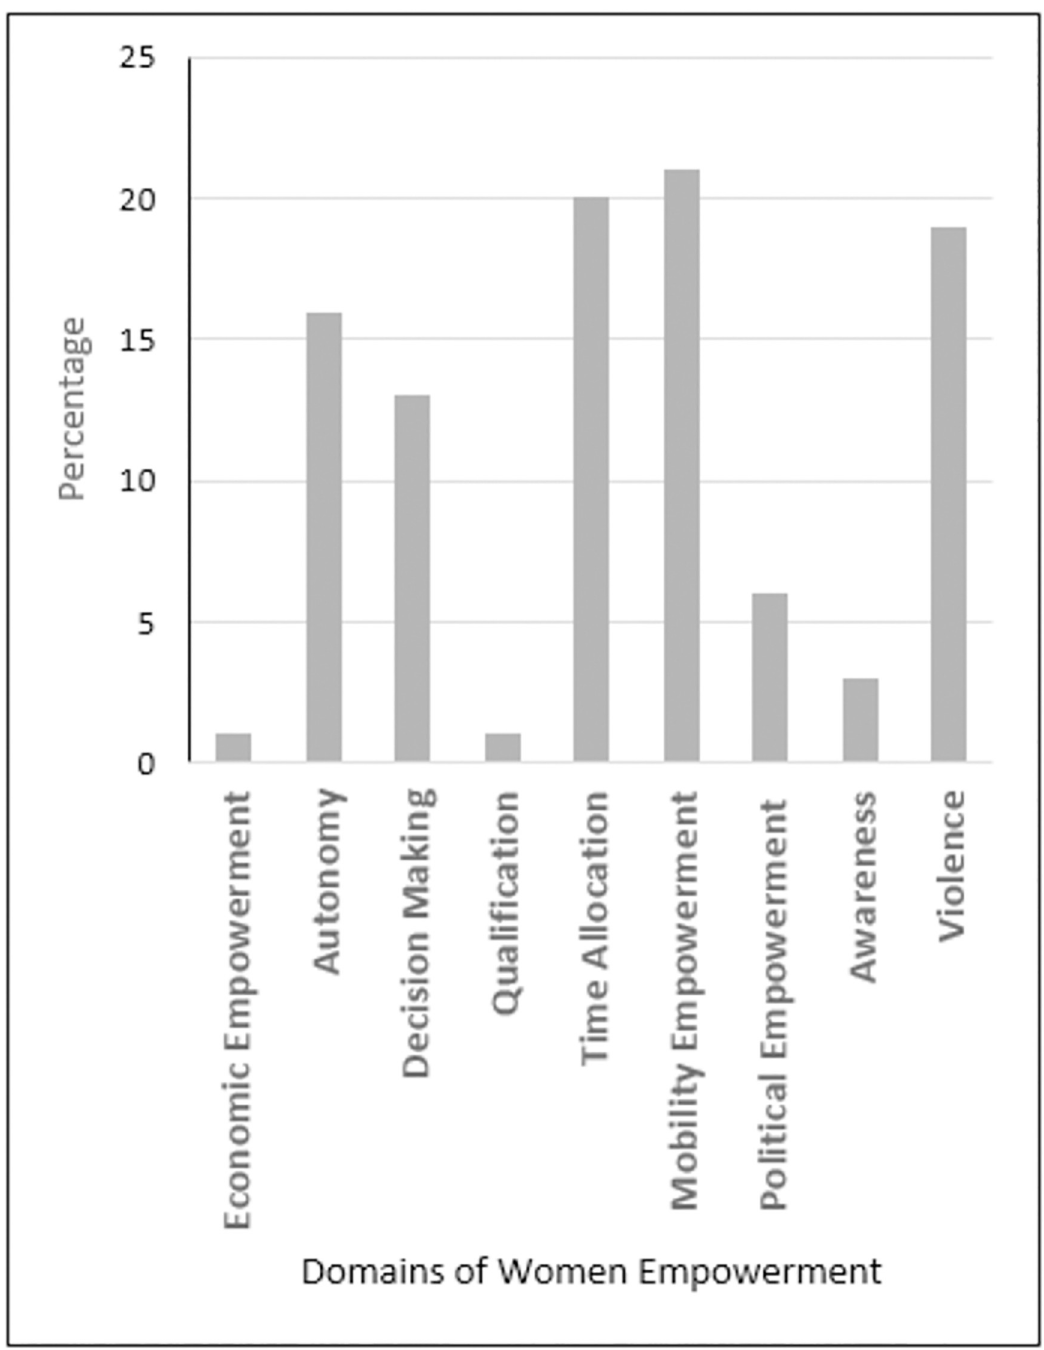
Fig 1. Proportion of domains explaining Rural Women’s Composite Empowerment Index. Source: Authors own